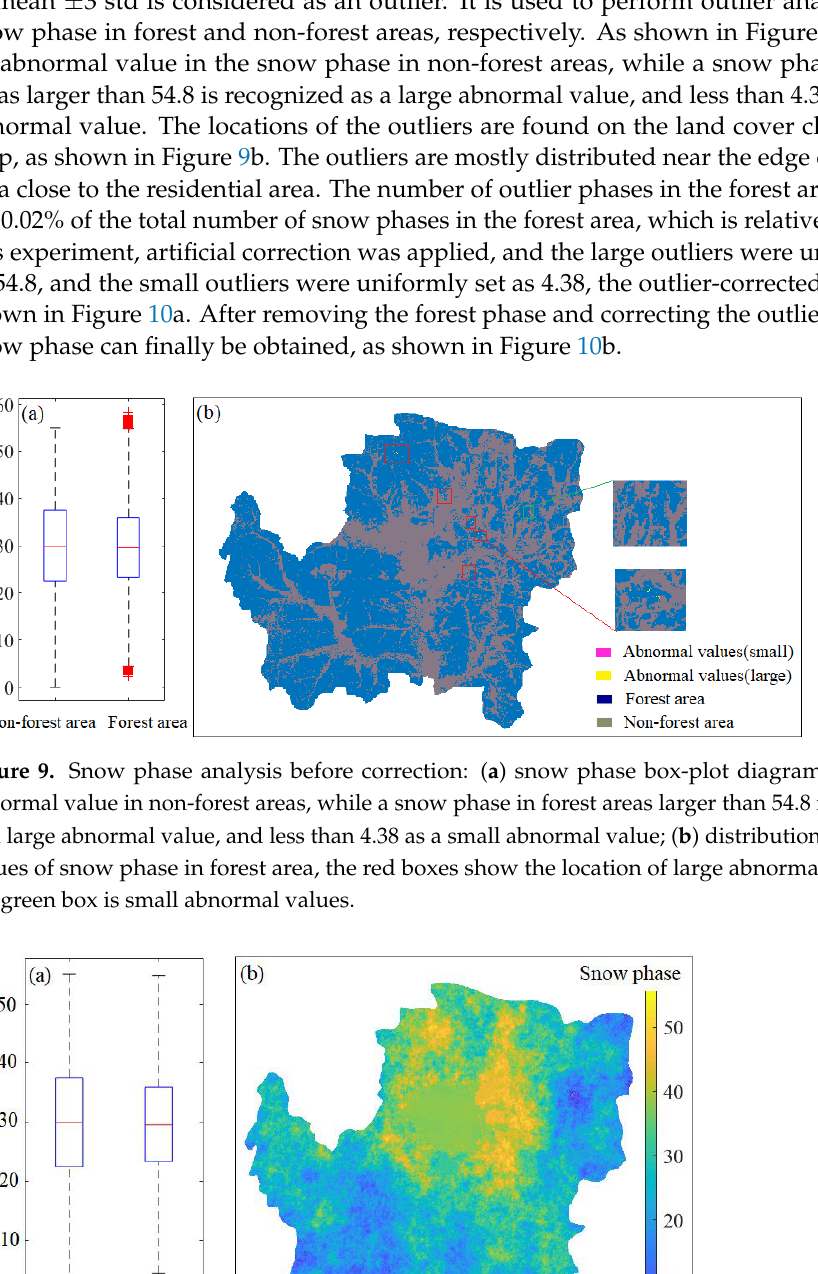
11 of 19 Figure 8. Data processing results: ( a ) interference phase diagram; ( b ) phase unwrapping diagram; ( c ) local incidence angle diagram. 4.1. Snow Depth Inversion Results